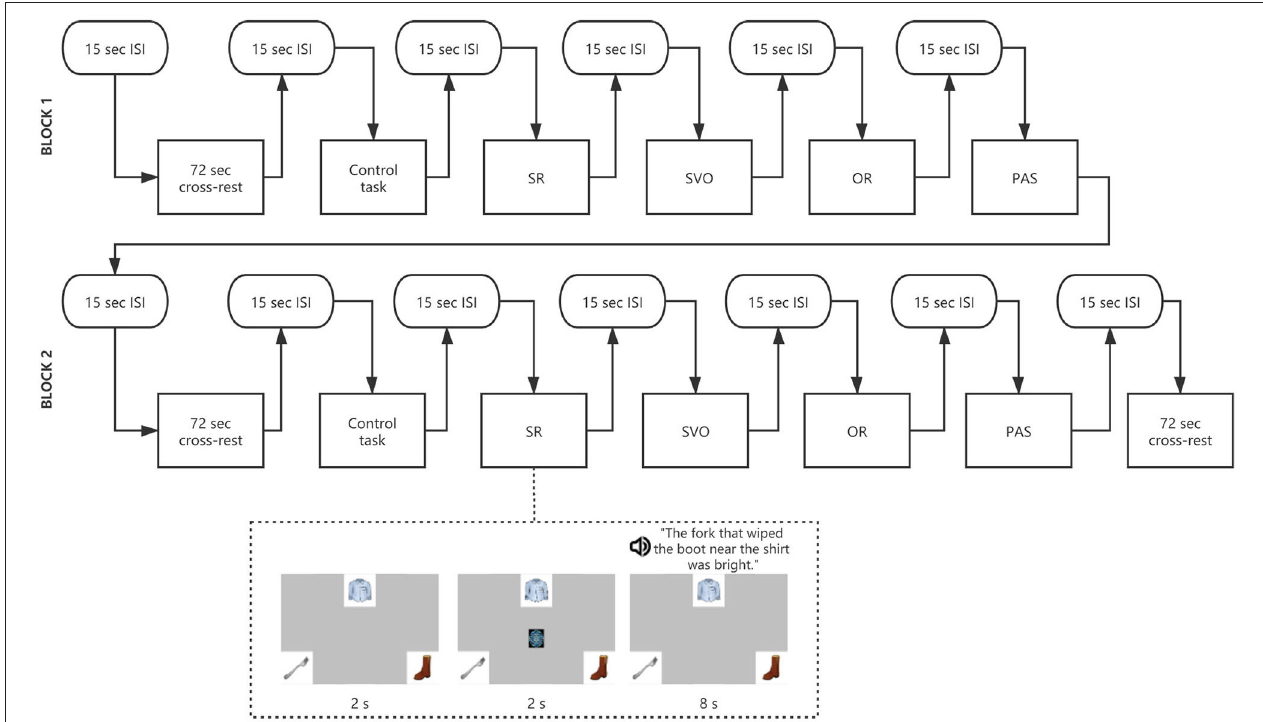
FIGURE 1 | The experimental design and examples of stimuli used in the experimental task.